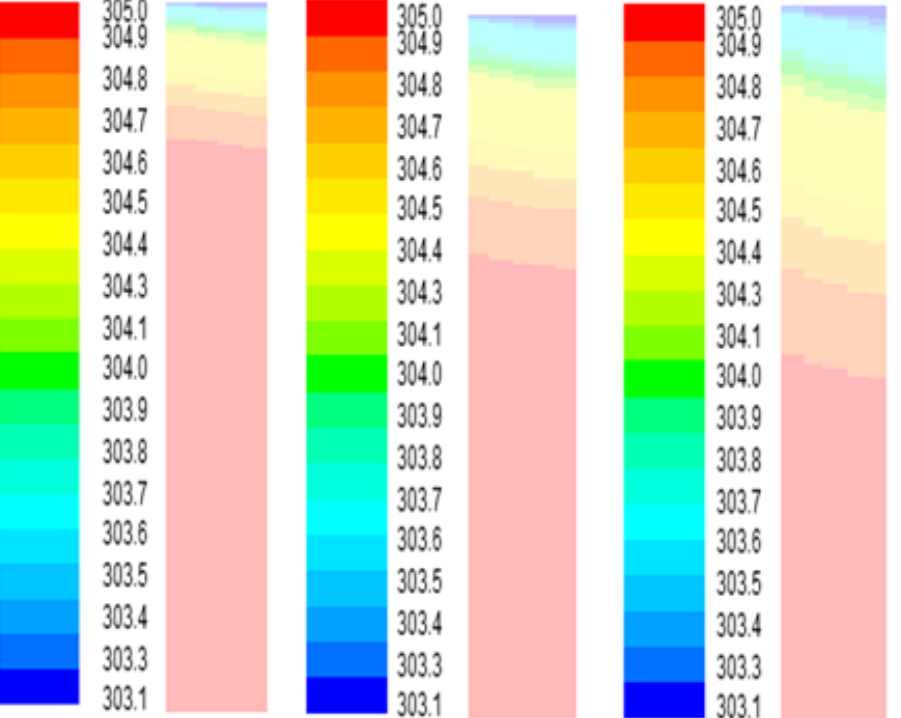
Figure 6. Comparison of maximum temperatures (K) obtained by changing Reynolds numbers (pure water).